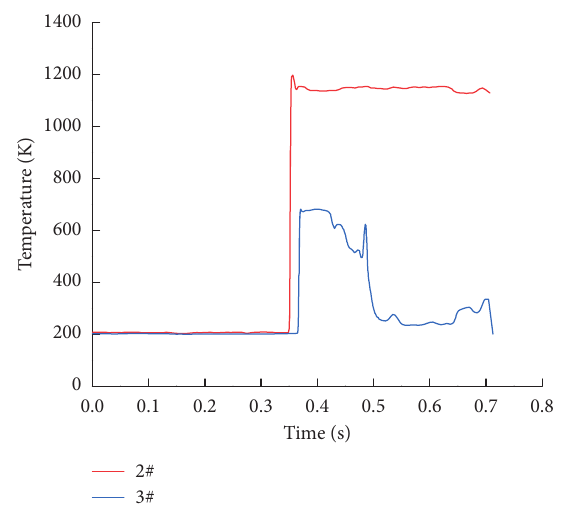
Figure 6: Curve of temperature at different measurement points with time.